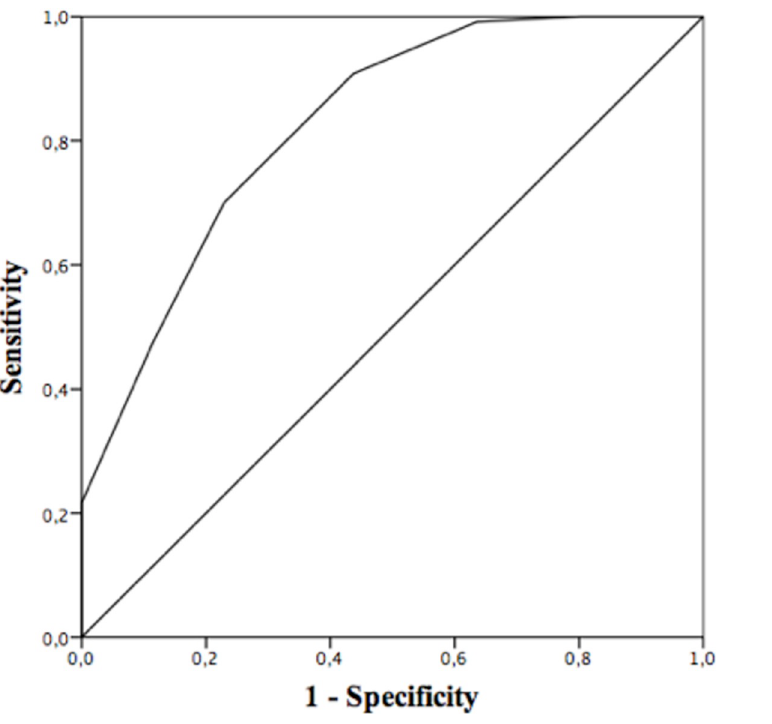
Fig 2. ROC curve for DTAOP (N = 216; AUC = 0.826, 95% CI, 0.772–0.881; P < 0.001).